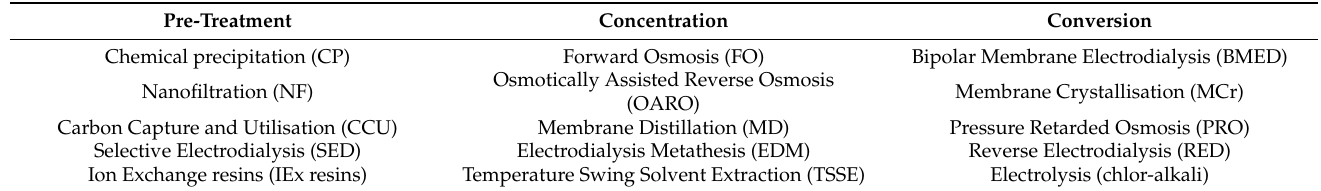
Table 1. Classification of the main desalination brine valorisation (DBV) technologies by stages, adapted from